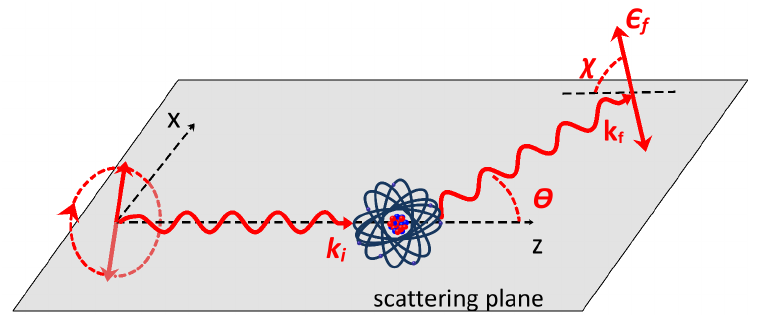
Figure 1. The geometry of the elastic photon-atom scattering. The scattering plane, chosen as xz plane, is defined by the wave vectors of the incoming and outgoing photons. The propagation direction of the incident photon is taken along the z axis. We are interested especially in the case when incident light is circularly polarized, and the linear polarization of the scattered radiation is